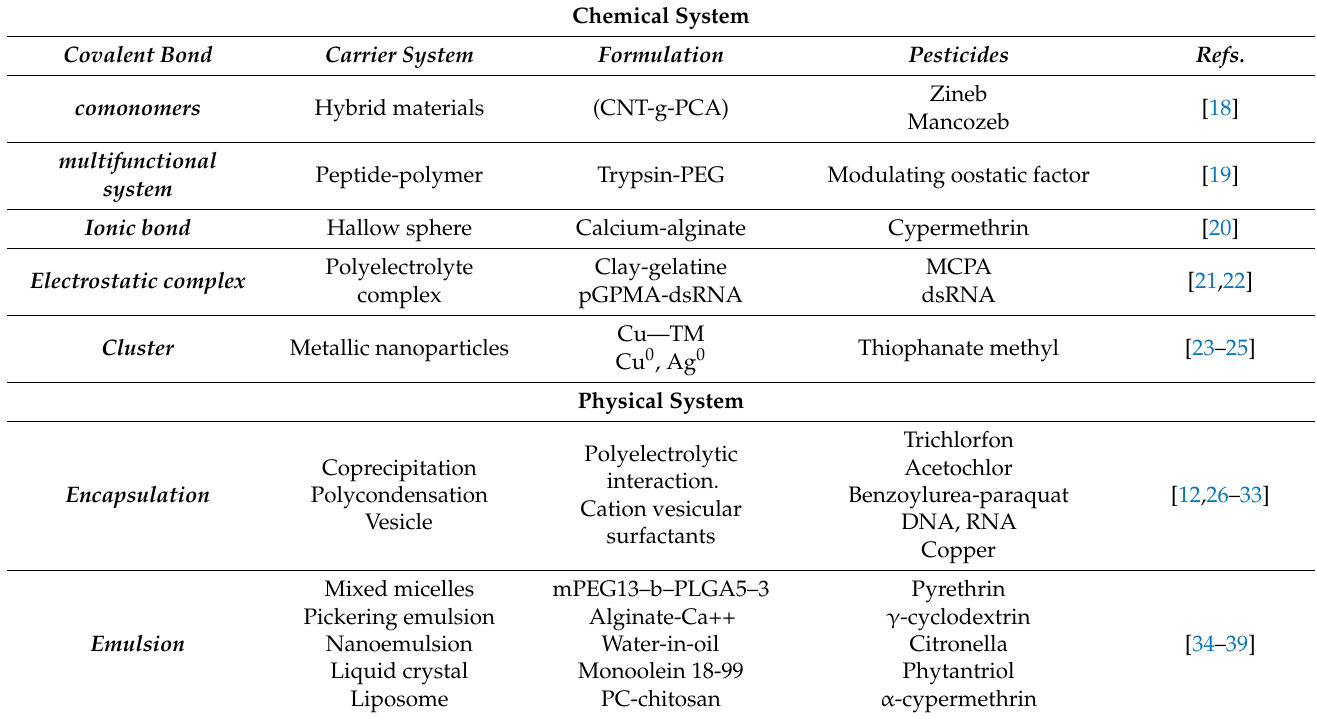
Table 1. Chemical and physical systems as carrier agents in nanopesticides formulation. Chemical